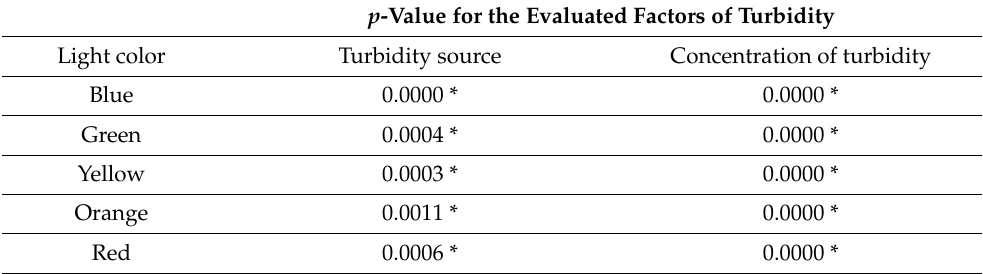
Table 3. Multifactorial ANOVA for the LDR resistances in the different lights. * Significant difference. p -Value for the Evaluated Factors of Turbidity Light color Turbidity source Concentration of turbidity Blue 0.0000 * 0.0000 * Green 0.0004 * 0.0000 * Yellow 0.0003 * 0.0000 * Orange 0.0011 * 0.0000 * Red 0.0006 * 0.0000